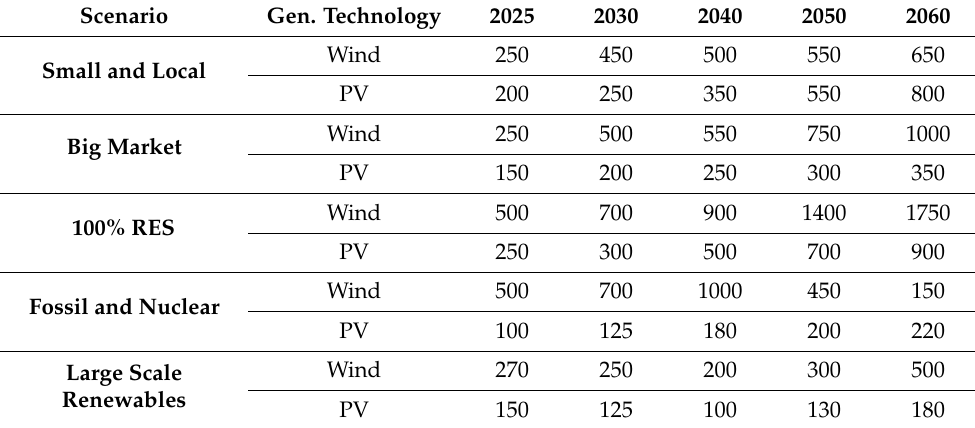
Table 4. Results for annual wind and PV generation